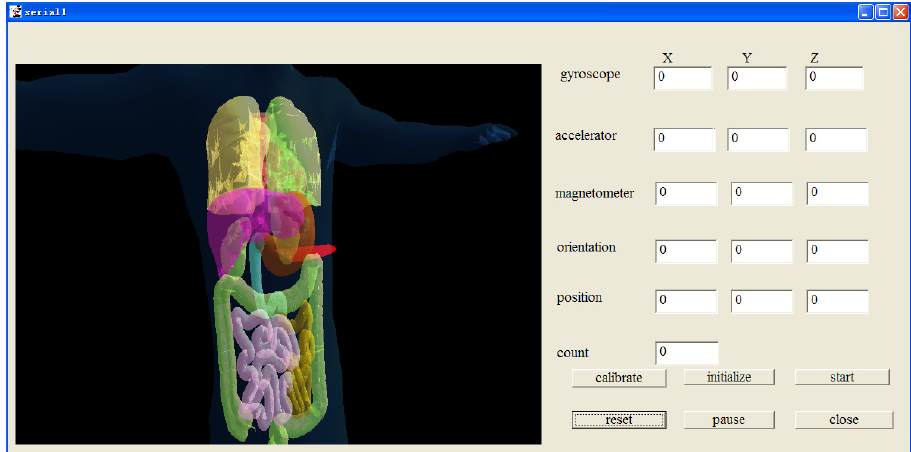
Figure 3. The interface of the ultrasonic endoscope tracking